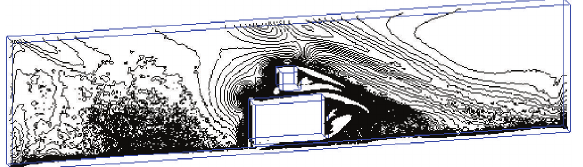
Figure 13: The effects of 𝑢 3 .